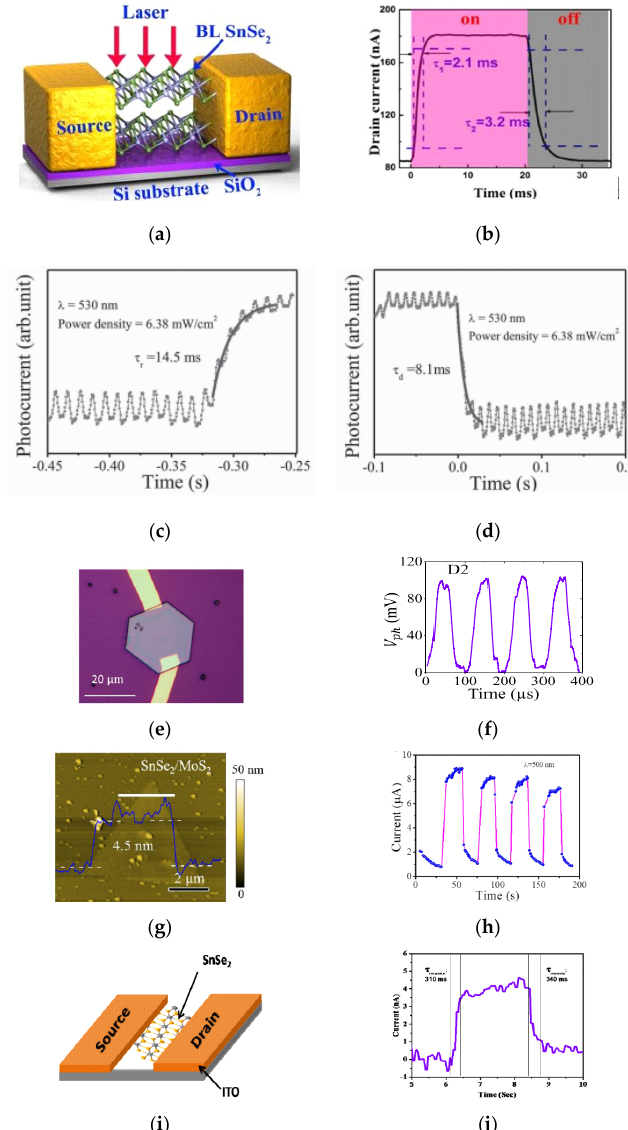
Figure 9. ( a ) Schematic representation of the photodetector device consisting of a bi-layered SnSe 2 on SiO 2 /Si wafer with laser illumination. ( b ) Photocurrent dynamics of one period of the time-resolved photoresponse. The laser used in ( b ) is 633 nm with a power of 4 mW. ( a , b ) are reproduced with permission from reference [81]. ( c , d ) Rise and decay curves measured using an oscilloscope and fitted with a single-exponential function. ( c , d ) are reproduced with permission from reference [3]. ( e , f ) Optical image of electrode deposited onto a SnSe 2 crystal (thickness ≈ 50 nm) to make the optoelectronic device, Rise and fall time for the SnSe 2 photoconductor within the microsecond regime. ( e , f ) are reproduced with permission from reference [82]. ( g , h ) AFM image of a typical SnSe 2 /MoS 2 hetero-structure, Time-dependent photoresponse of the photodetector under 500 nm light illumination. ( g , h ) are reproduced with permission from reference [83]. ( i , j ) Schematic of fabricated two probe device with few-layer SnSe 2 and typical single I-t curve for response and recovery time measurements. ( i , j ) are reproduced with permission from reference